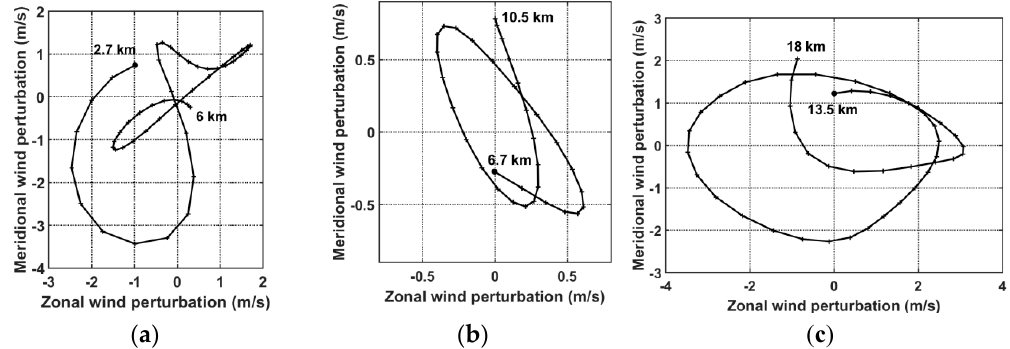
Figure 12. ( a ), ( b ) and ( c ) similar as Figure 11 but in the TC eye (23° N, 123.2° E).